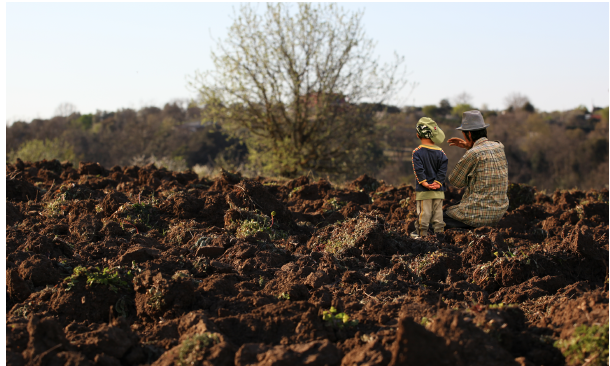
Figure 1. In the heart of the sustainability concept, the connection with the land and respectfulness between generations lies in the ba- sics and secrets about how to care for soil, which are transferred from older generations to the youth. © Matteo